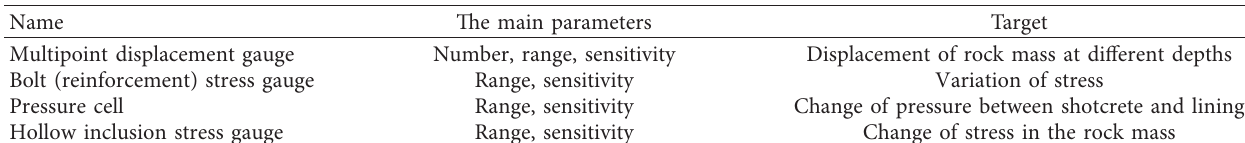
Figure 13: Collapse of borehole. (a) Broken core and (b) caving of borehole. Table 1: Multiple sensing elements of rock mass-support